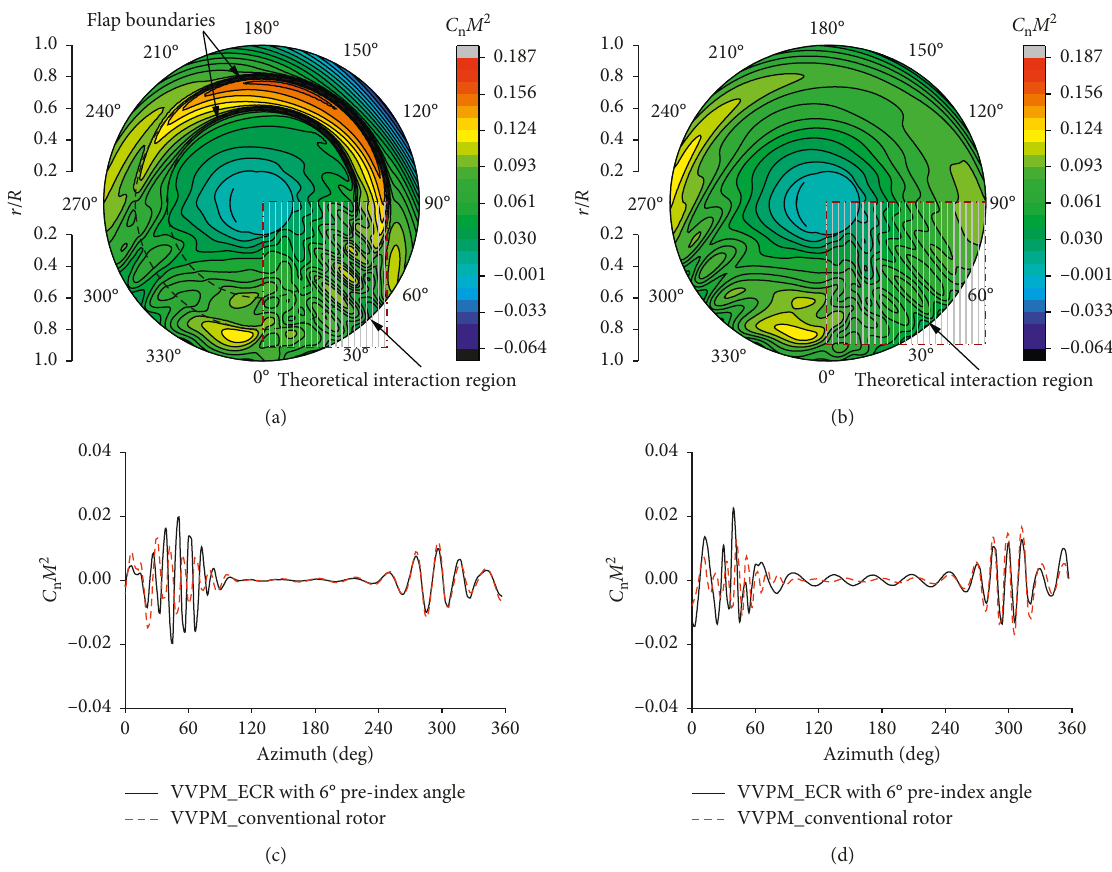
Figure 7: BVI-induced airloads of the ECR and conventional rotor. (a) Disc airloads distribution of the ECR with 6 ∘ pre-index angle; (b) disc airloads distribution of the conventional rotor; (c) high-frequency ( > 10/rev) section normal force C M 2 at 87% span frequency ( > 10/rev) section normal force C n